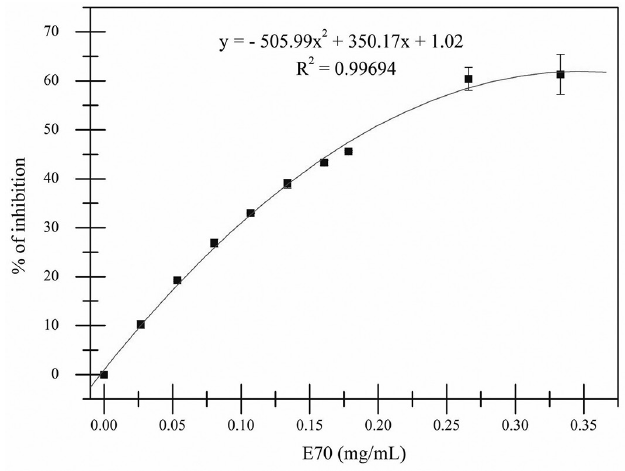
FIGURE 3 - Inhibition percentage of WST-1 formazan by the E70 extract.